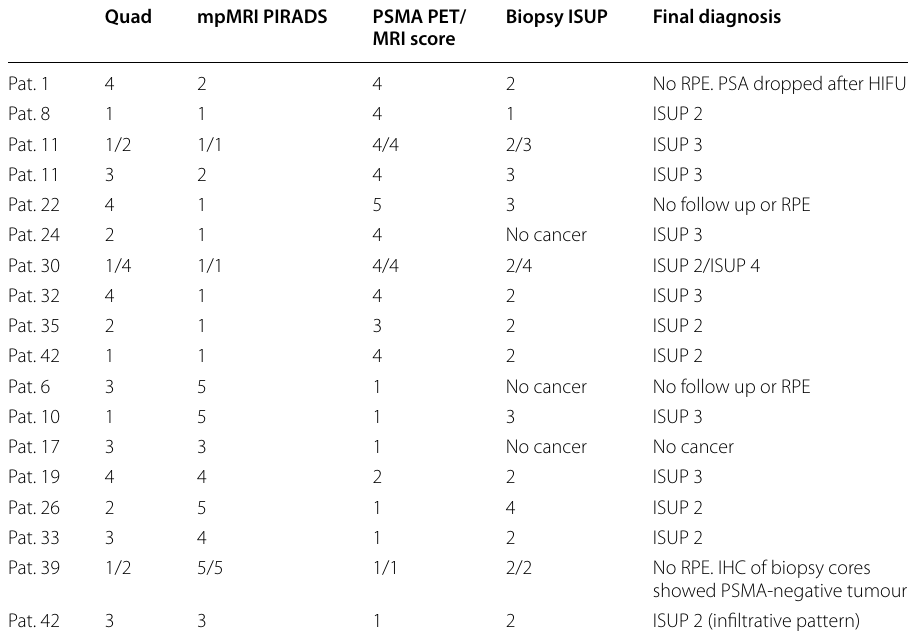
Table 3 Imaging and histopathological findings of quadrants with disagreement between PSMA PET/MRI and mpMRI ( n 21*) =